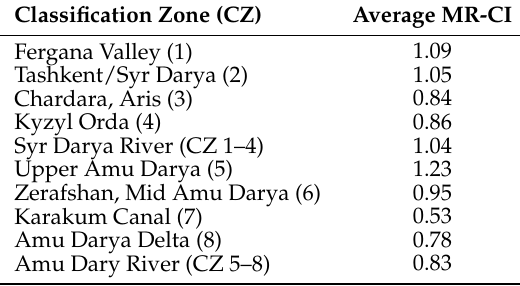
Table 6. Regional cropping intensity based on MODIS data (MR-CI) averaged over the observation period from 2000 to 2012 and for the classification zones (CZ) in the according river system.